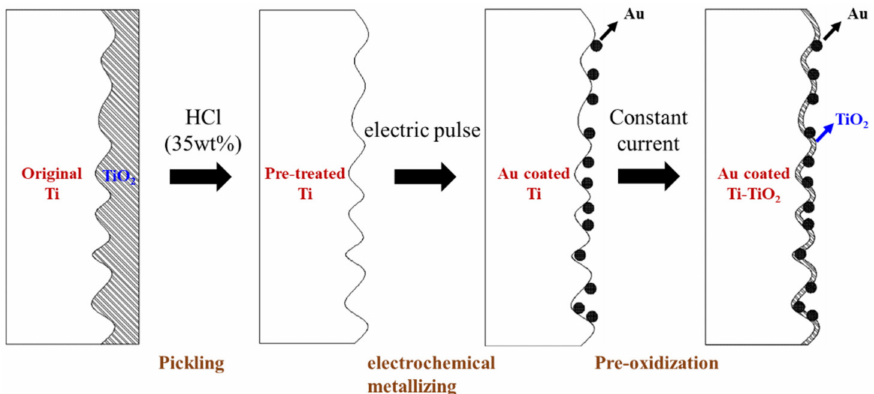
Figure 1. Schematic illustration of the formation of Au-TiO 2 /Ti hybrid